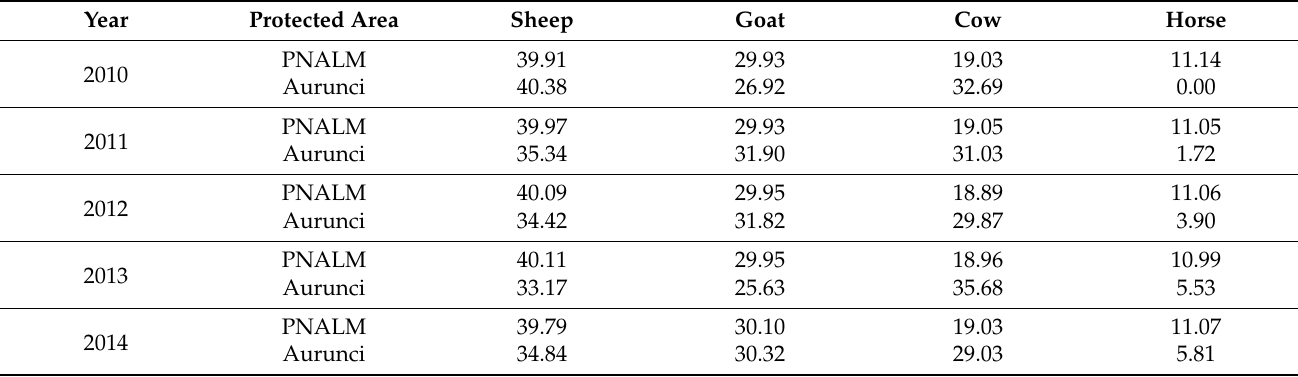
Table 5. Percentage of domestic animals preyed by wolves in Italian studied areas. (National Park Abruzzo, Lazio, and Molise = PNALM; Regional Park of Aurunci Mountain = Aurunci). Year Protected Area Sheep Goat Cow Horse PNALM 2010